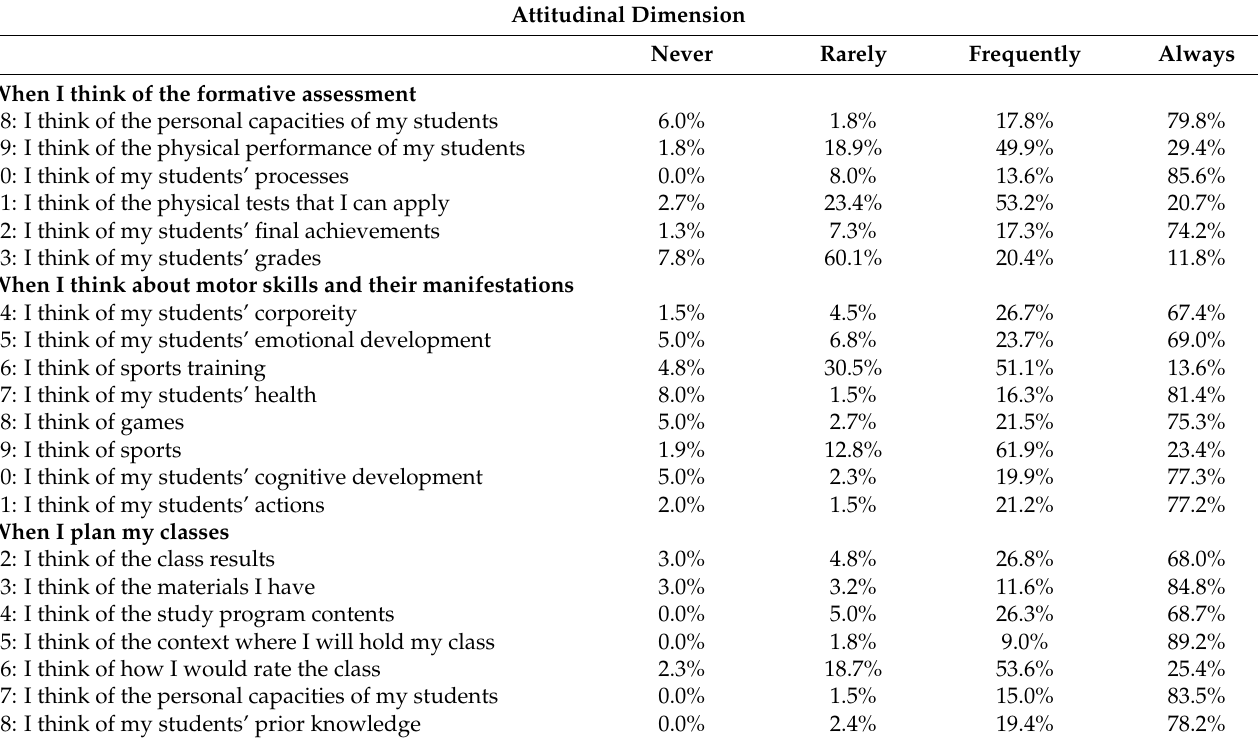
Table 5. Descriptive results for the attitudinal